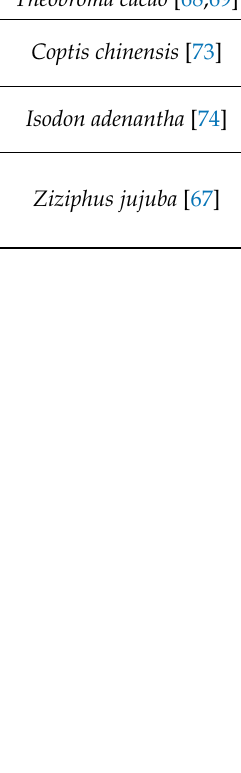
Table 5. Herbs containing nutraceuticals indirectly acting on PPAR